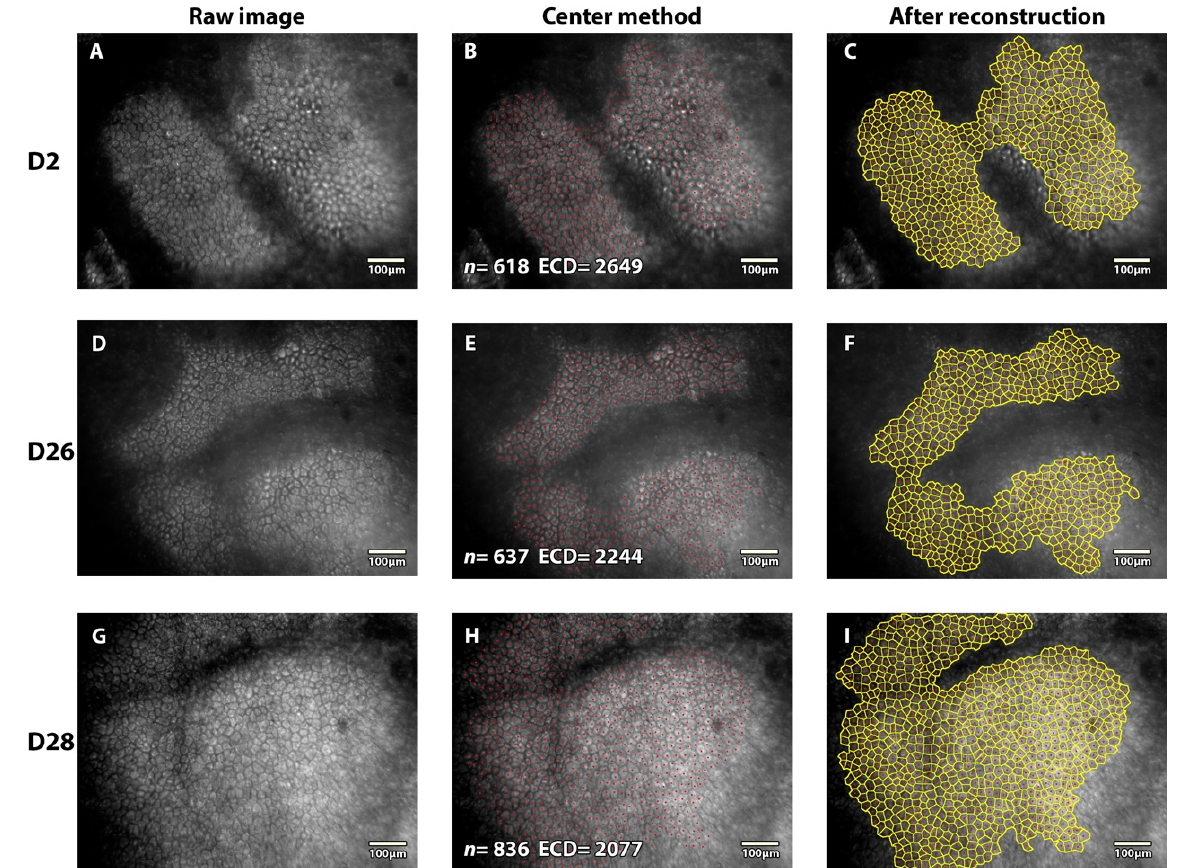
Figure 5. Example of specular microscopy images of the same area of the same cornea stored in the active storage machine for one month . An accurate monitoring of endothelial cell density was possible at day (D) 2, 26, and 28. n = number of cells counted; ECD endothelial cell density in cells/mm 2 . At D2, ( A ) raw image with endothelial cells, ( B ) each center was pointed according to the center method, ( C ) cells borders and each center were marked thanks to ImageJ plugin ECD3D [16]. At D26, ( D ) comparative raw image showed larger cells, ( E ) ECD count was determined with the same method, ( F ) reconstruction allowed global view of the studied sample. At D28, ( G ) progressive redistribution of cells occurred, ( H ) more cells were counted on a larger area inside the same field of view (less endothelial folds), ( I ) reconstruction highlighted polymegethism and